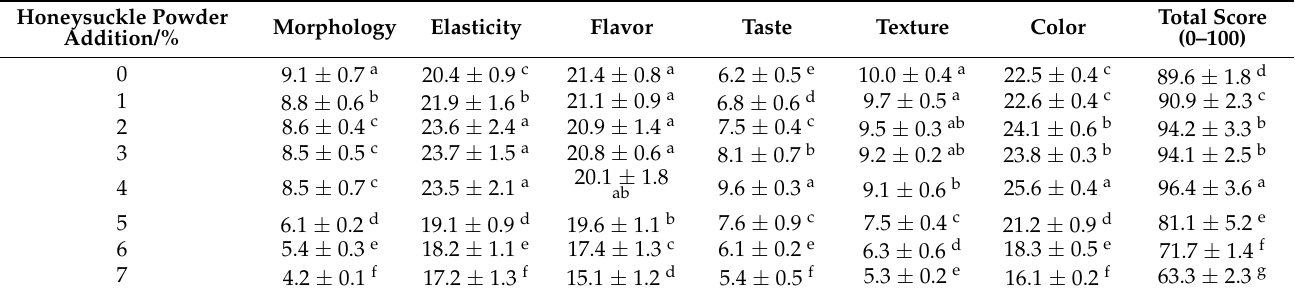
Note: Different lowercase letters in the same column indicate a significant difference ( p < 0.05), while the same lowercase letters indicate no significant difference ( p >